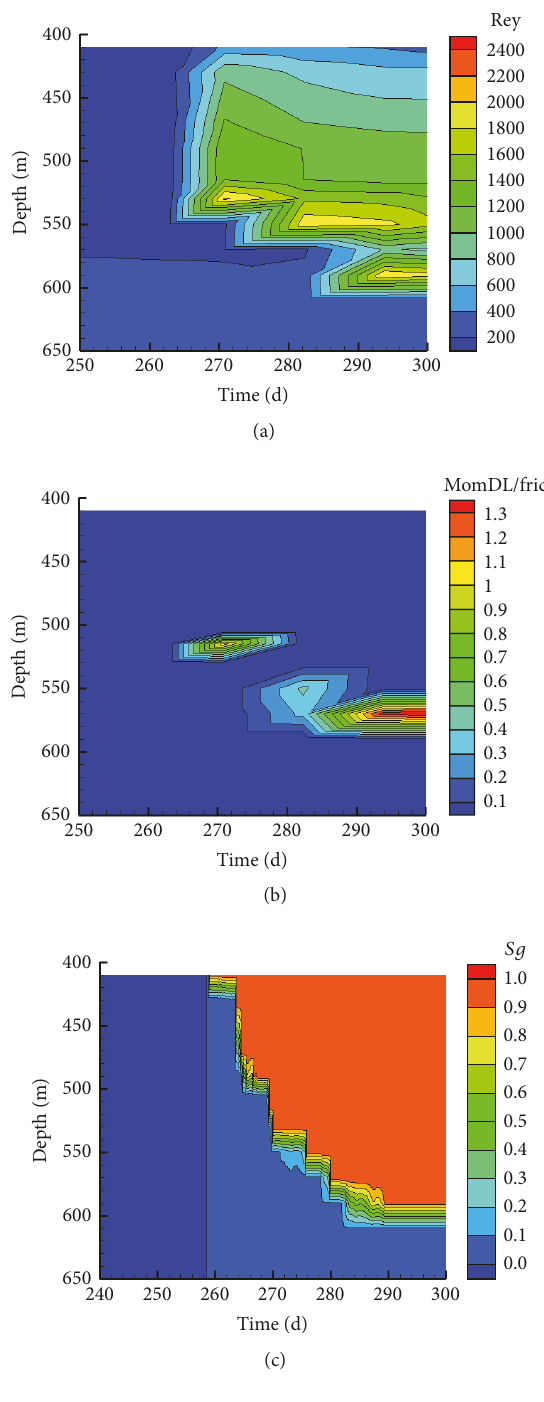
Figure 8: Profiles of Reynold number and the ratio of momentum over friction gradient at top zone of the fracture in Case 1 before and after gas phase